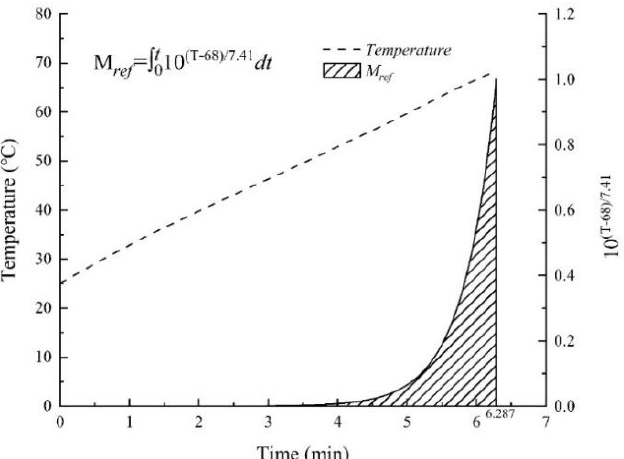
Figure 7. Average temperature–time history of five locations (A–E) in Figure 3 of RF heating from 25 to 68 °C, and the equivalent lethal time M ref for this heating up curve of Aspergillus inoculated in almond kernels with a w of 0.854 at 68 °C.